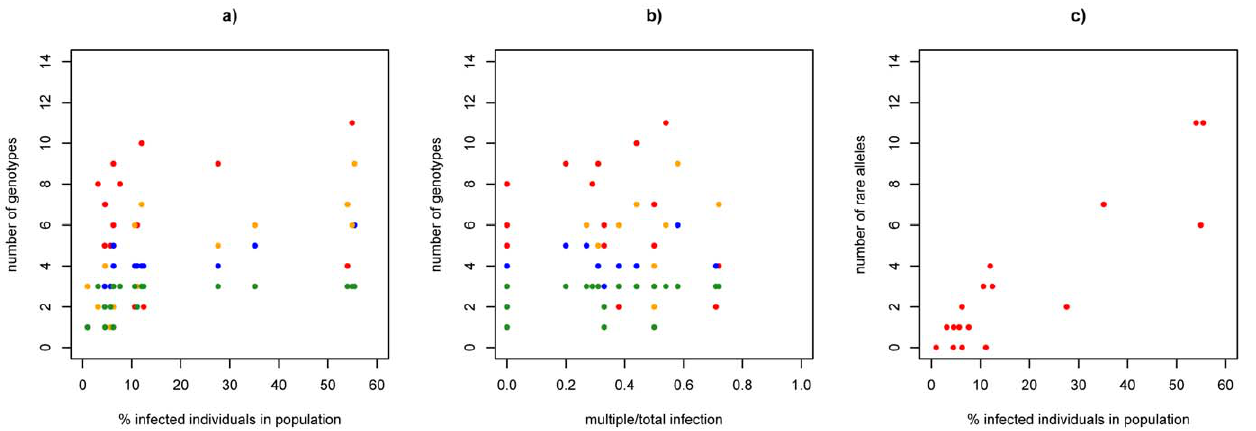
Figure 2. Correlation between a) the number of genotypes found in a population and the percentage of infected individuals in that respective population, b) the number of genotypes in a population and the fraction of multiple infections per total infections in that respective population, and c) the number of rare alleles found in a population and the percentage of infected individuals in that respective population. The respective loci are marked as follows: red=4.G9, yellow=2.F10, blue=4, green=16. (See text for